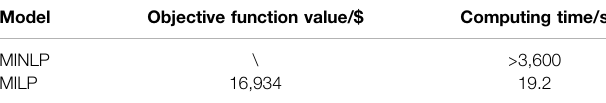
TABLE 2 | Convergence and solving ef fi ciency of different